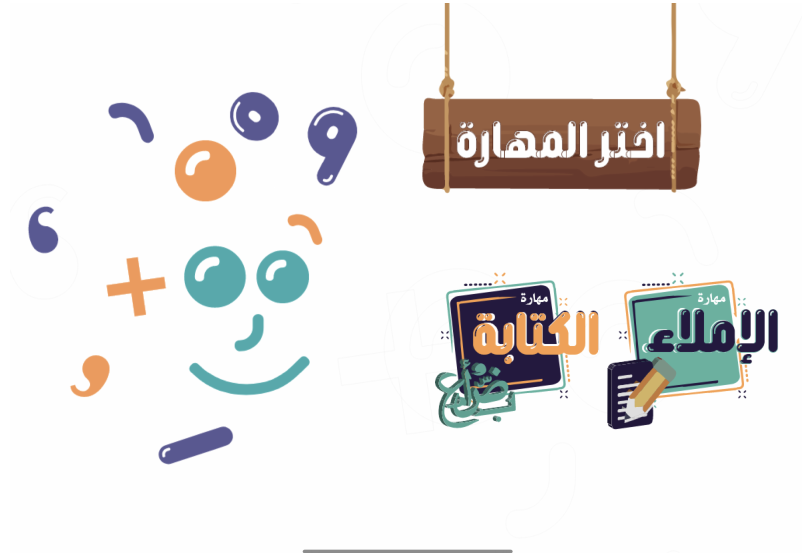
Figure 3. Homepage interface.